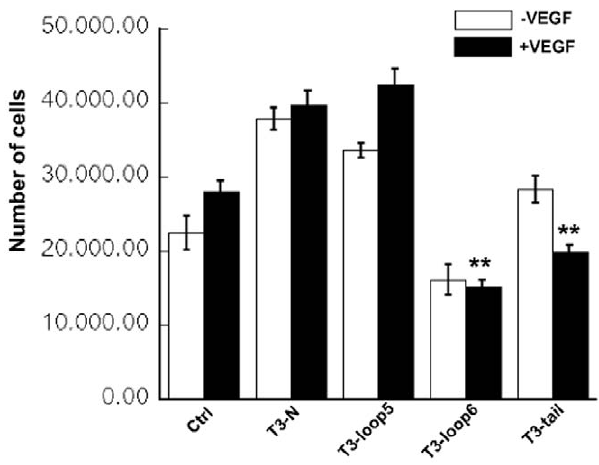
Figure 6. Effects of TIMP-3 peptides on VEGF-mediated EC proliferation. TIMP-3 loop 6 and tail but not loop 5 and N-peptide inhibit VEGF-induced proliferation in PAE/KDR cells. Serum-starved cells were incubated with or without VEGF (5 ng/ml) in the presence or absence of the 1 m M of TIMP-3 peptides for 5 days. Cell numbers were counted using a Coulter particle counter. **significantly different from control (with VEGF), p , 0.01 (Student’s t test). VEGFR-2 band (pVEGFR-2) as well as the total VEGFR-2 band (KDR) was performed. The ratio of pVEGFR-2:VEGFR-2 was determined and compared between peptide treatments (Fig. 3b). 20 m M T3-loop 5 or T3-N peptide failed to inhibit VEGF-induced receptor activation (Fig. 3c).